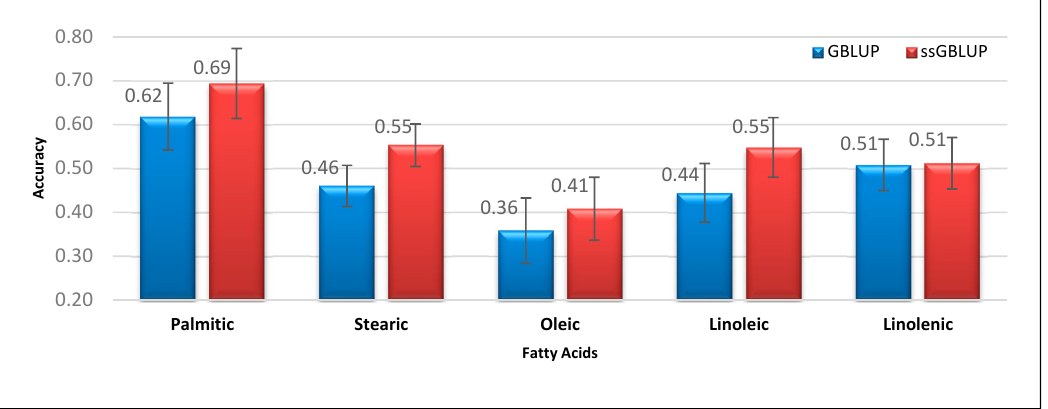
Figure 3. Prediction accuracies and standard errors obtained using GBLUP and ssGBLUP for palmitic, stearic, oleic, linoleic, and linolenic acids.